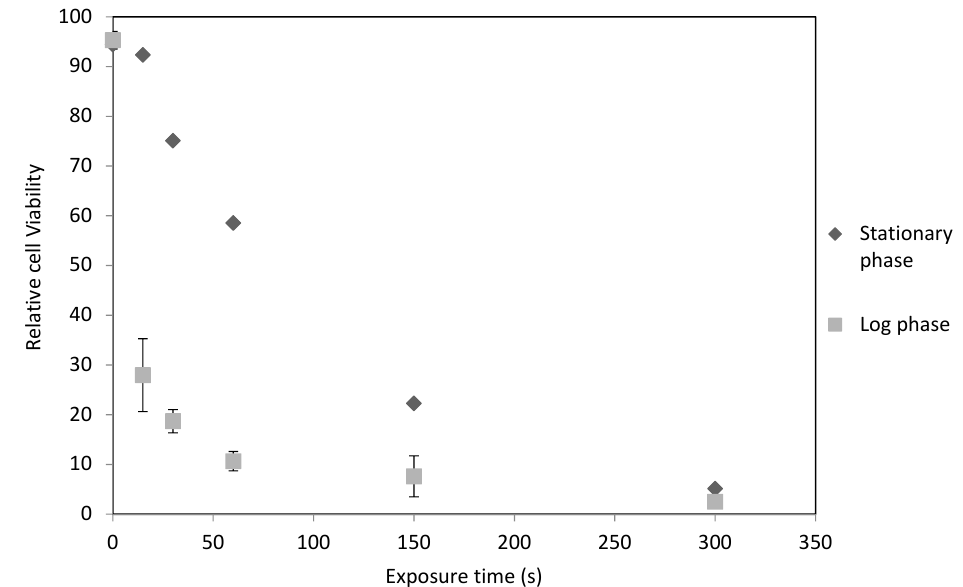
Figure 2. Relative cell viability of C. reinhardtii at various exposure times to ultraviolet light in the stationary and active growth phases. Stationary phase n = 1, log phase n = 3. Error bars represent the range for log phase. Control at 0 s of irradiation. UVB intensity at 1.5 W/cm 2 . Carried out as described in Materials and Methods. Culture densities approximately 0.7 mg/mL dry weight.